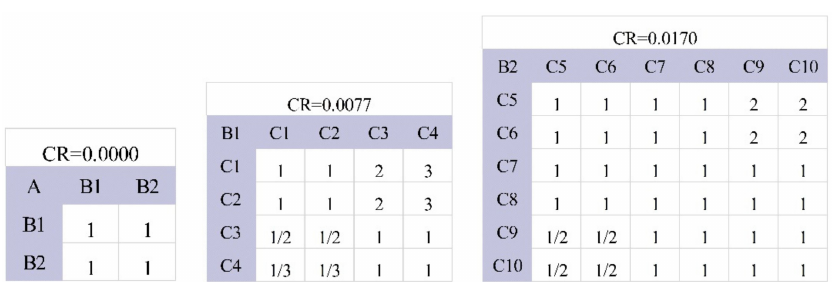
Figure 10. Pairwise comparison matrix. (A) SII, (B1) visual perception factors of public space, (B2) spatial perception factors of urban facilities, (C1) SVE, (C2) SVS, (C3) SVH, (C4) SHDI, (C5) C-T, (C6) C-R, (C7) C-O, (C8) C-SH, (C9) C-G, (C10) C-C. Table 5. Hierarchy and metric weight of settlement intention index (SII) model. Target